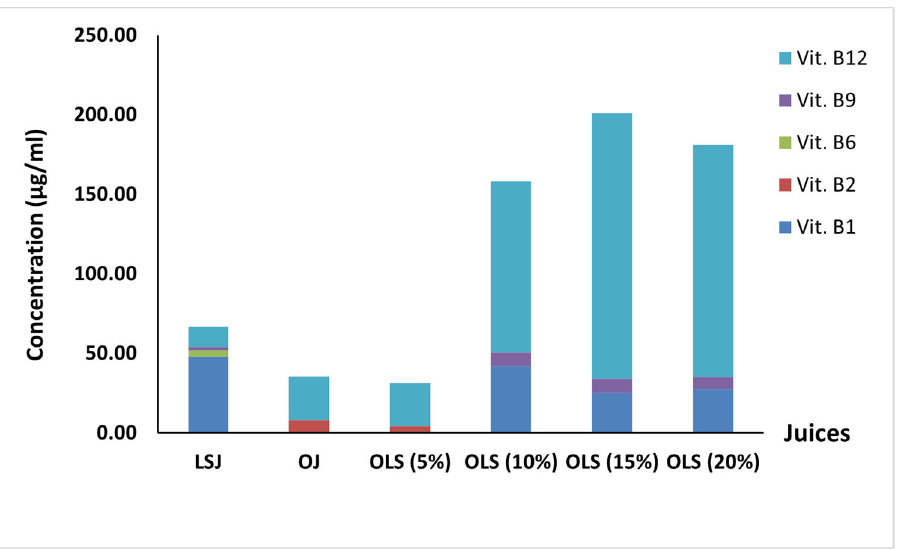
Figure 2. Vitamin B content of orange juice mixed with beetroot leaf–stem juice in different propor ‐ tions.